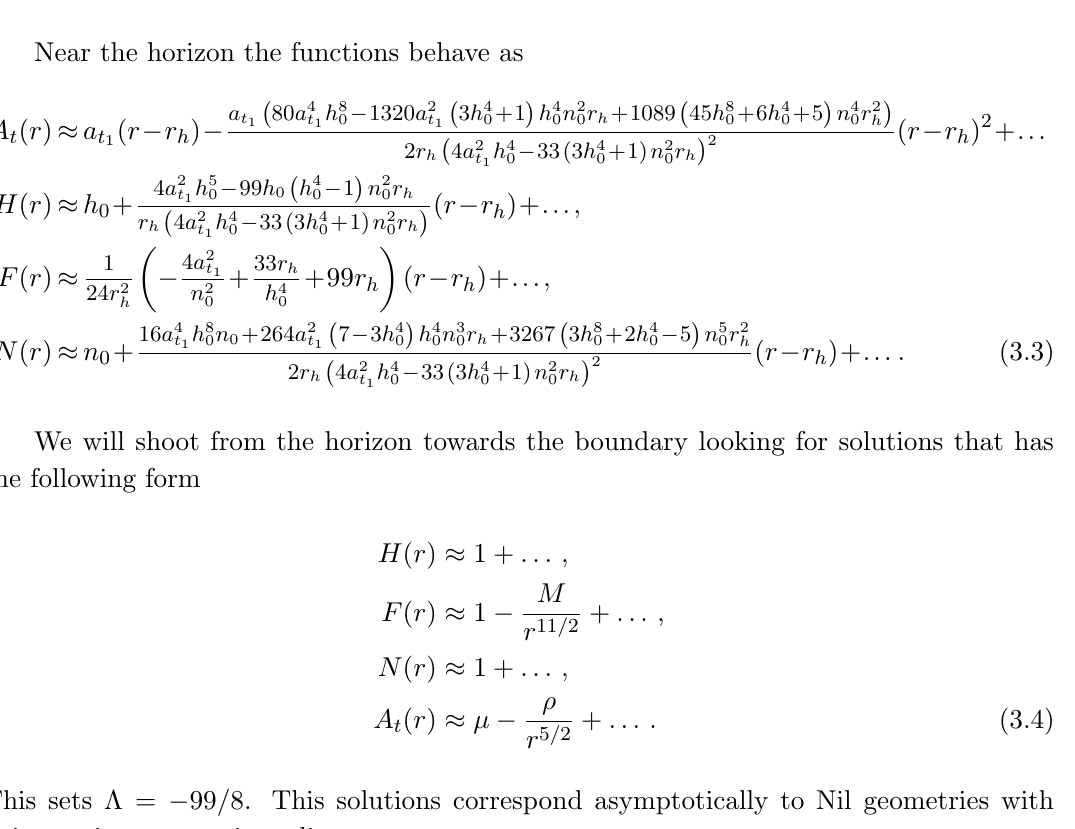
Figure 4 . Left: radial pro(cid:12)les for the (cid:12)elds F (Blue), A t (Purple), H (Yellow) and N (Green) for (cid:22) = 1 : 53. Right: termperature T (Blue), black hole mass M (Purple), black hole entropy S (Yellow) and charge density (cid:26) (Green) for the dual (cid:12)eld theory as a function of the chemical potential (cid:22) .